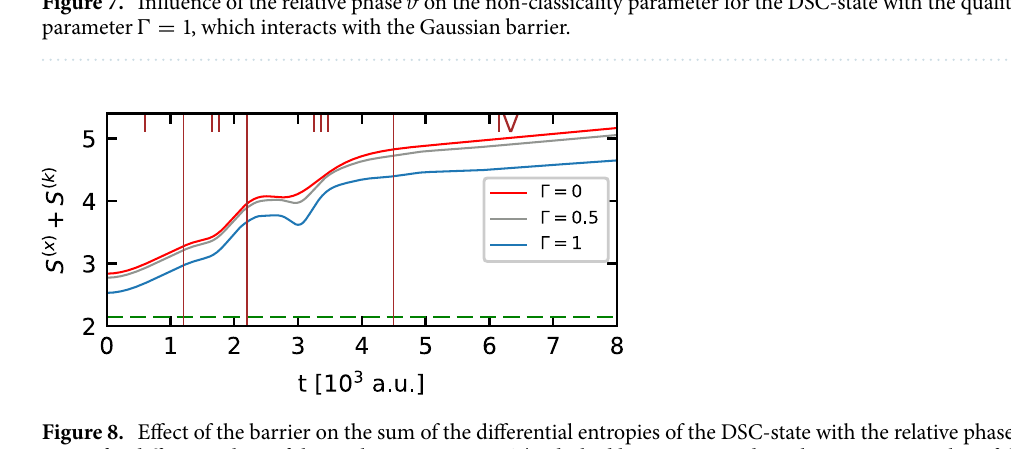
Figure 8. Effect of the barrier on the sum of the differential entropies of the DSC-state with the relative phase ϑ = 0 for different values of the quality parameter Ŵ . The dashed line corresponds to the mimimum value of the sum of differential entropies according to Eq.